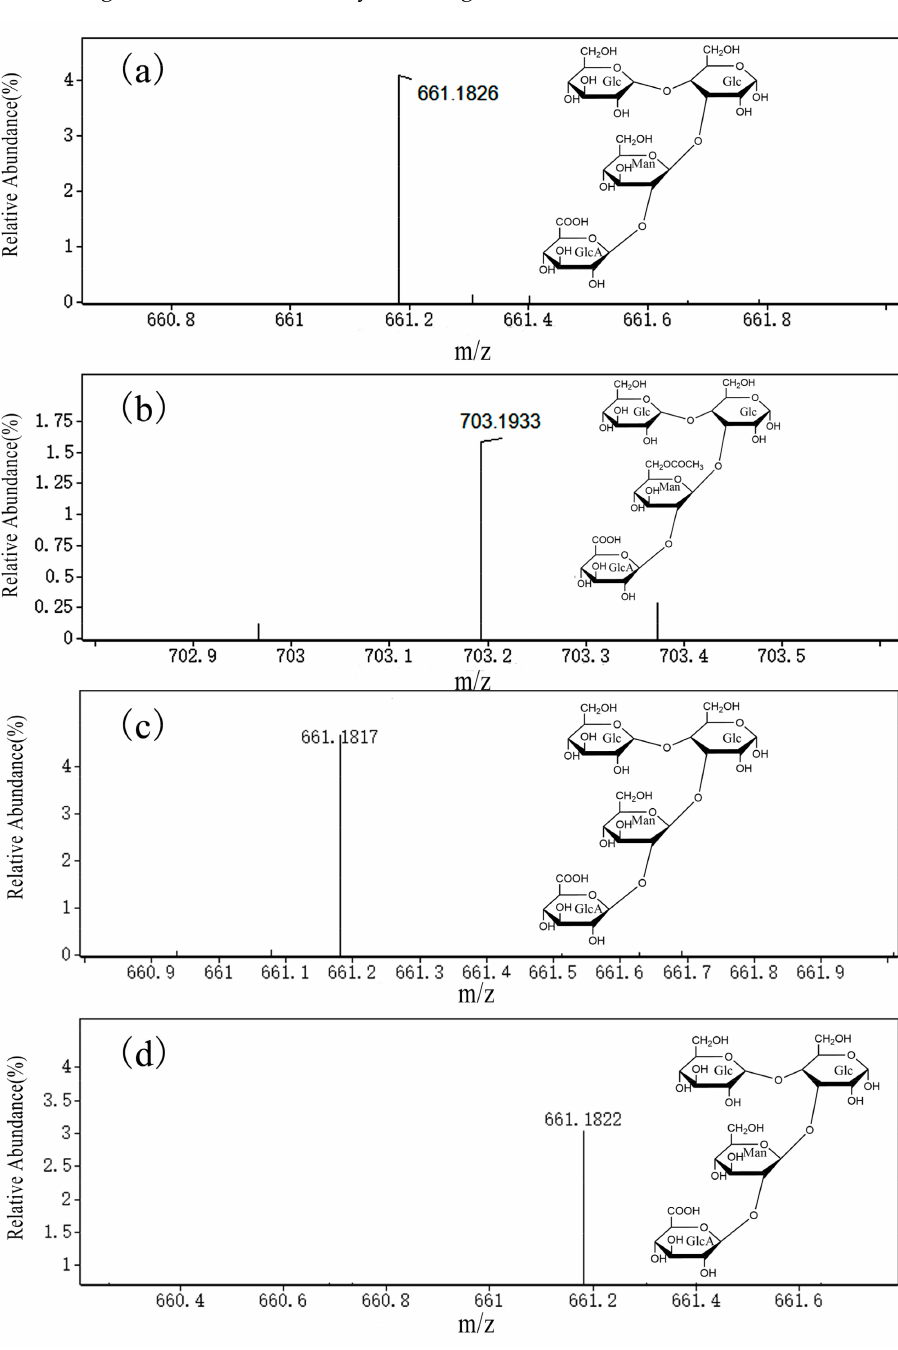
Figure 8. Ultra-high-performance liquid chromatography/quadrupole time-of-flight mass spectrometry analysis of the unsaturated tetrasaccharides produced by hydrolysis of xanthan. ( a , b ) Xanthan digested by Mi Xen-CBM84; ( c ) xanthan digested by Mi Xen-CBMx; ( d ) xanthan digested by Mi